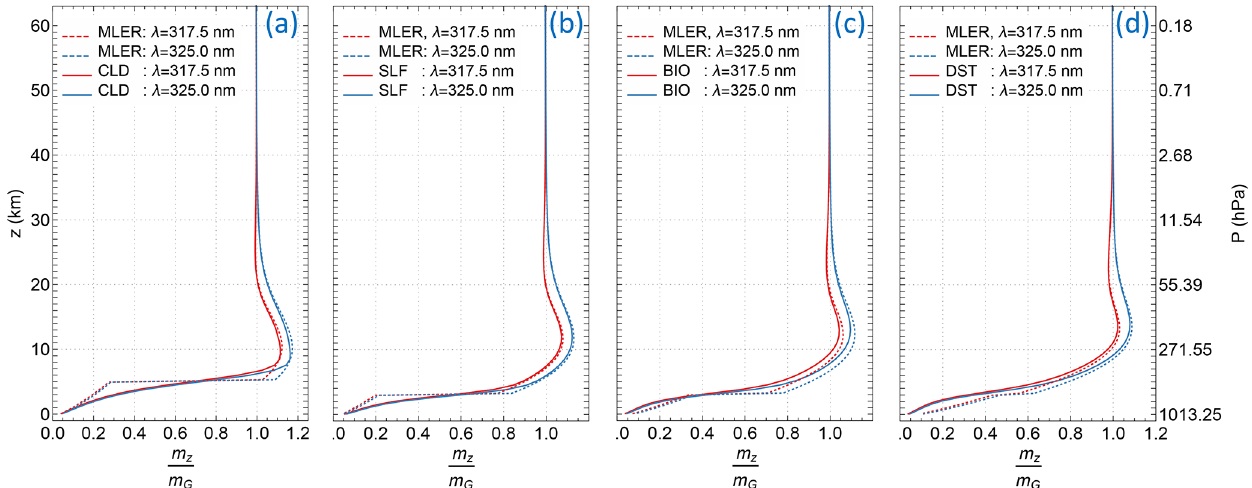
Figure 9. Mean photon path lengths m z , normalized by the geometric AMF m G , of EPIC bands 1 and 2 as functions of altitude z for particle- laden atmospheres and their MLER treatments. See the caption of Fig. 8 for the description of aerosol characterizations, MLER treatments, and the viewing illumination